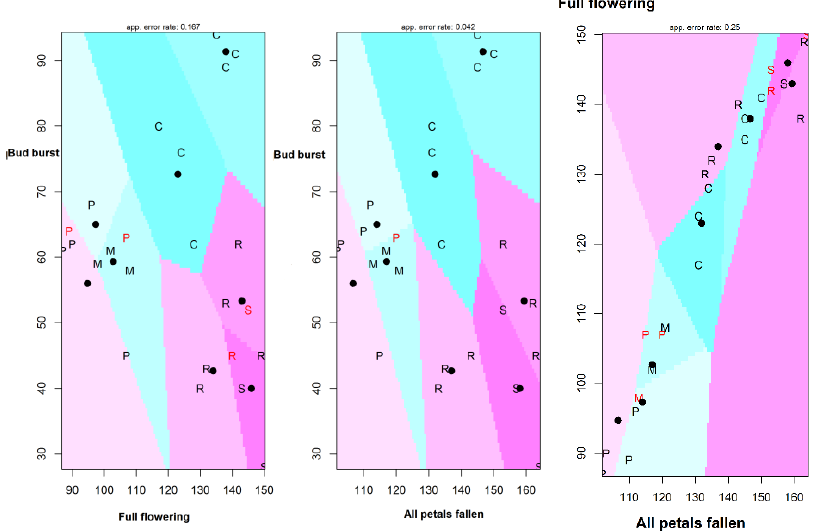
Figure 4. Partition plot results of “ full flowering ” , “ all petals fallen ” and “ bud burst ”